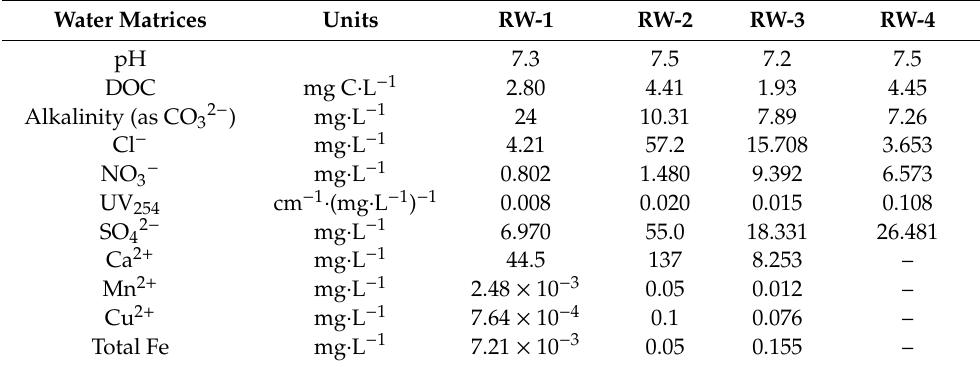
Figure 6. LC-MS spectra of ACE and its degradation products. Table 1. Water quality of the four real waters